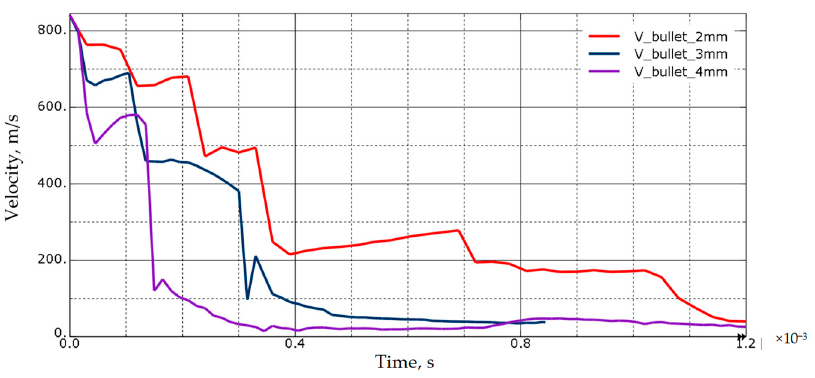
Figure 11. The 4 mm thick hull bullet penetration results.